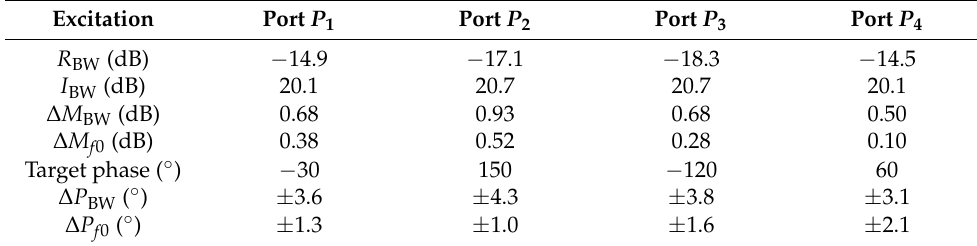
Figure 11. Butler matrix 2: EM-model-based magnitude (gray) and phase (black) responses of the optimized structure. Table 3. Butler matrix 2: performance figures of the optimized structure (EM simulation).